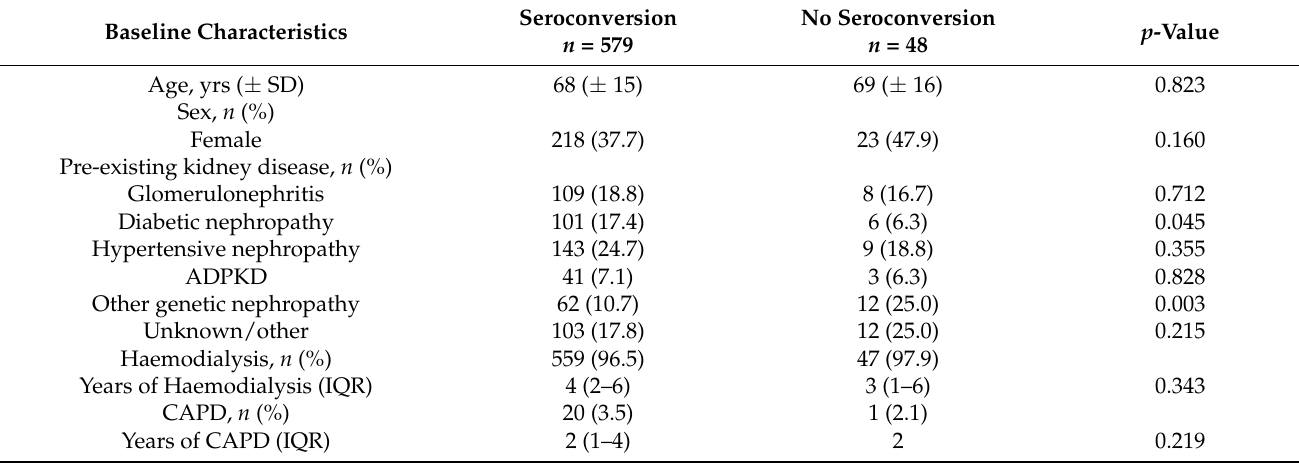
Table 2. Baseline characteristics of SARS-CoV-2-naïve dialysis patients with determined anti-SARS- CoV-2 serology after vaccination or infection. ADPKD: autosomal dominant polycystic kidney disease; CAPD: continuous ambulatory peritoneal dialysis; IQR: interquartile range; SARS-CoV-2: severe acute respiratory syndrome coronavirus type 2; SD: standard deviation; yrs: